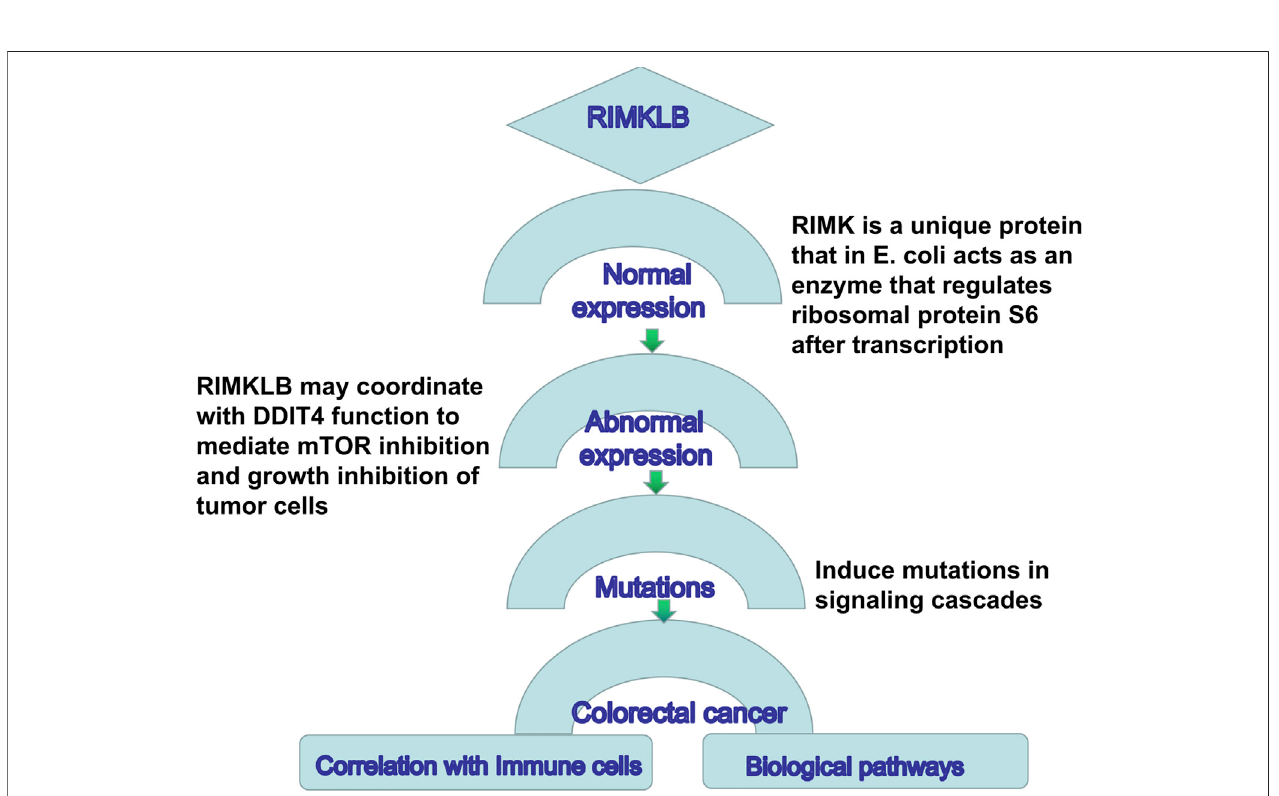
FIGURE 9 | Schematic representation for functional relevance of RIMKLB gene in the oncogenesis of colorectal cancer and its candidature as a correlation with immune cells and biological pathways.